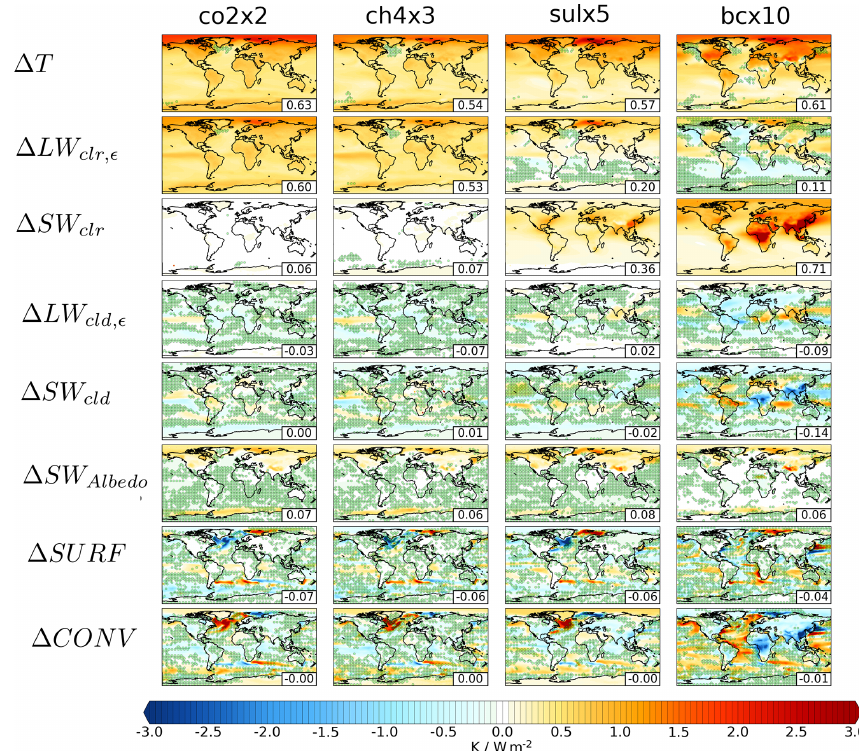
Figure 4. The multimodel-mean effective temperature response (row 1) for four different climate forcers, i.e., carbon dioxide (column 1), methane (column 2), sulfate (column 3), and black carbon (column 4), and its decomposition into different energy balance terms (long- and shortwave clear-sky ( (cid:49) LW clr , (cid:49) SW clr ), clouds, surface energy exchange ( (cid:49) SURF), and horizontal energy transport ( (cid:49) CONV)). Dotted areas show regions where only 4 out of the 6 models agree on the sign of the